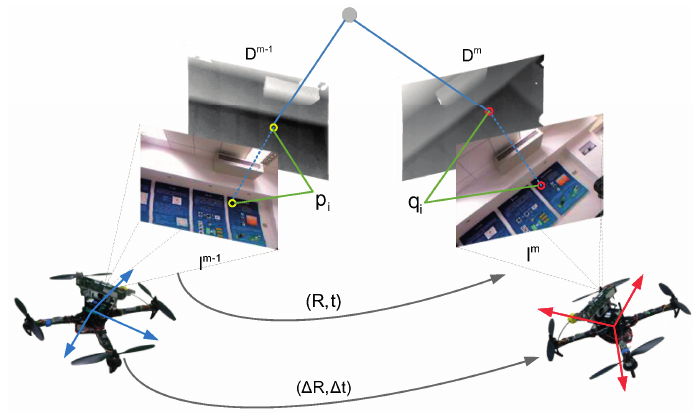
Figure 5. Relative motion estimation of MAV based on the RGB-D visual